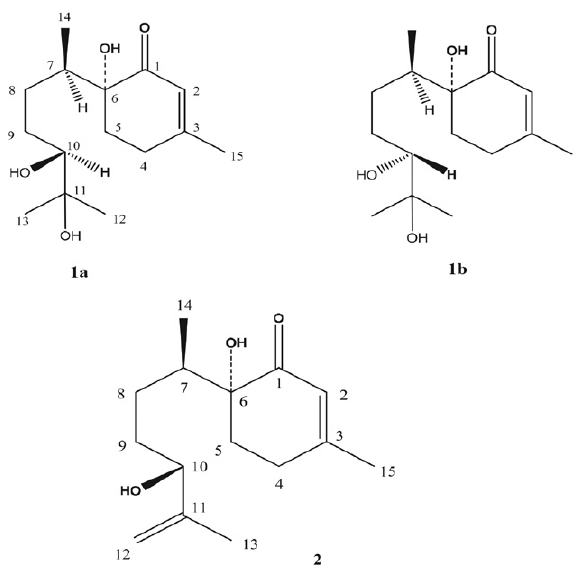
Figure 1 . Molecular structures of compounds 1a , 1b and